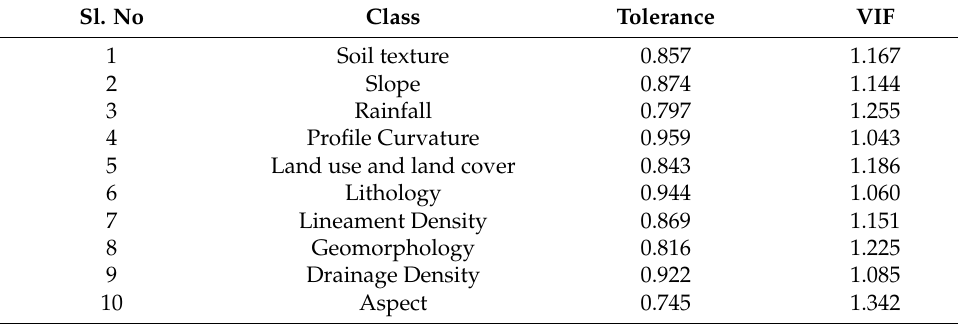
Table 4. The multicollinearity analysis for landslide conditioning factors.